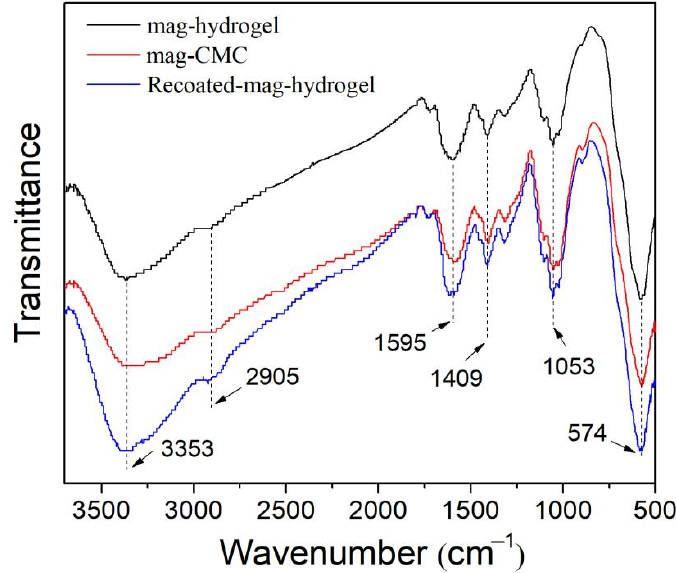
Polymers 2021 , 13 , x FOR PEER REVIEW Figure 3. FTIR spectra of magnetic nanocomposites. Figure 3. FTIR spectra of magnetic nanocomposites.